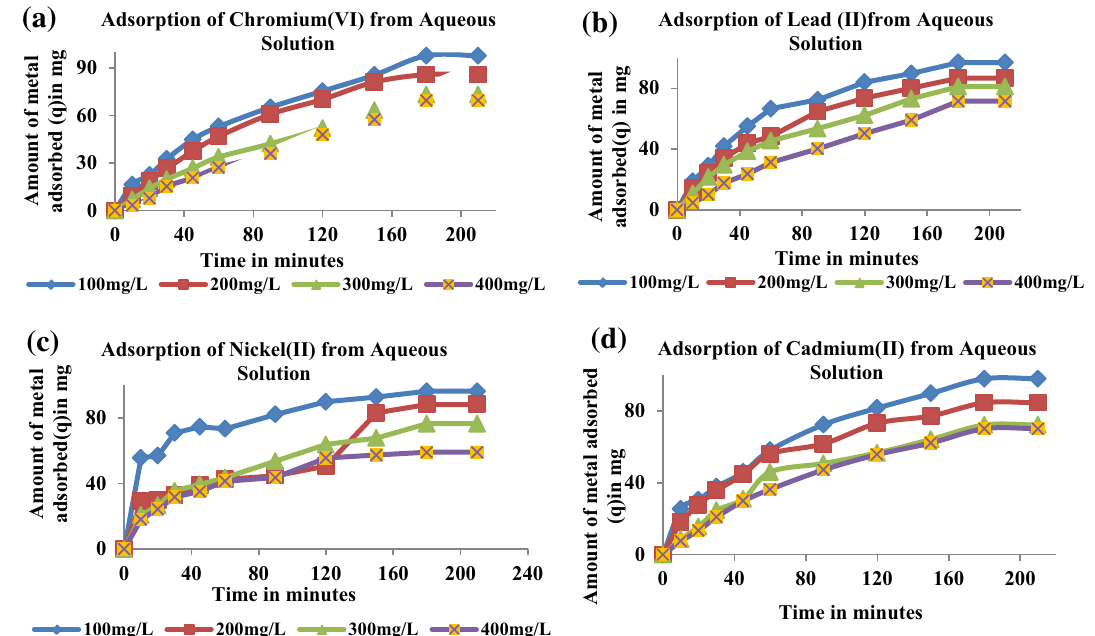
Fig. 1 a Kinetic curve related to adsorption of Cr(VI). From aqueous solution. b Kinetic curve related to adsorption of Pb(II). From aque- ous solution. c Kinetic curve related to adsorption of Ni(II). From